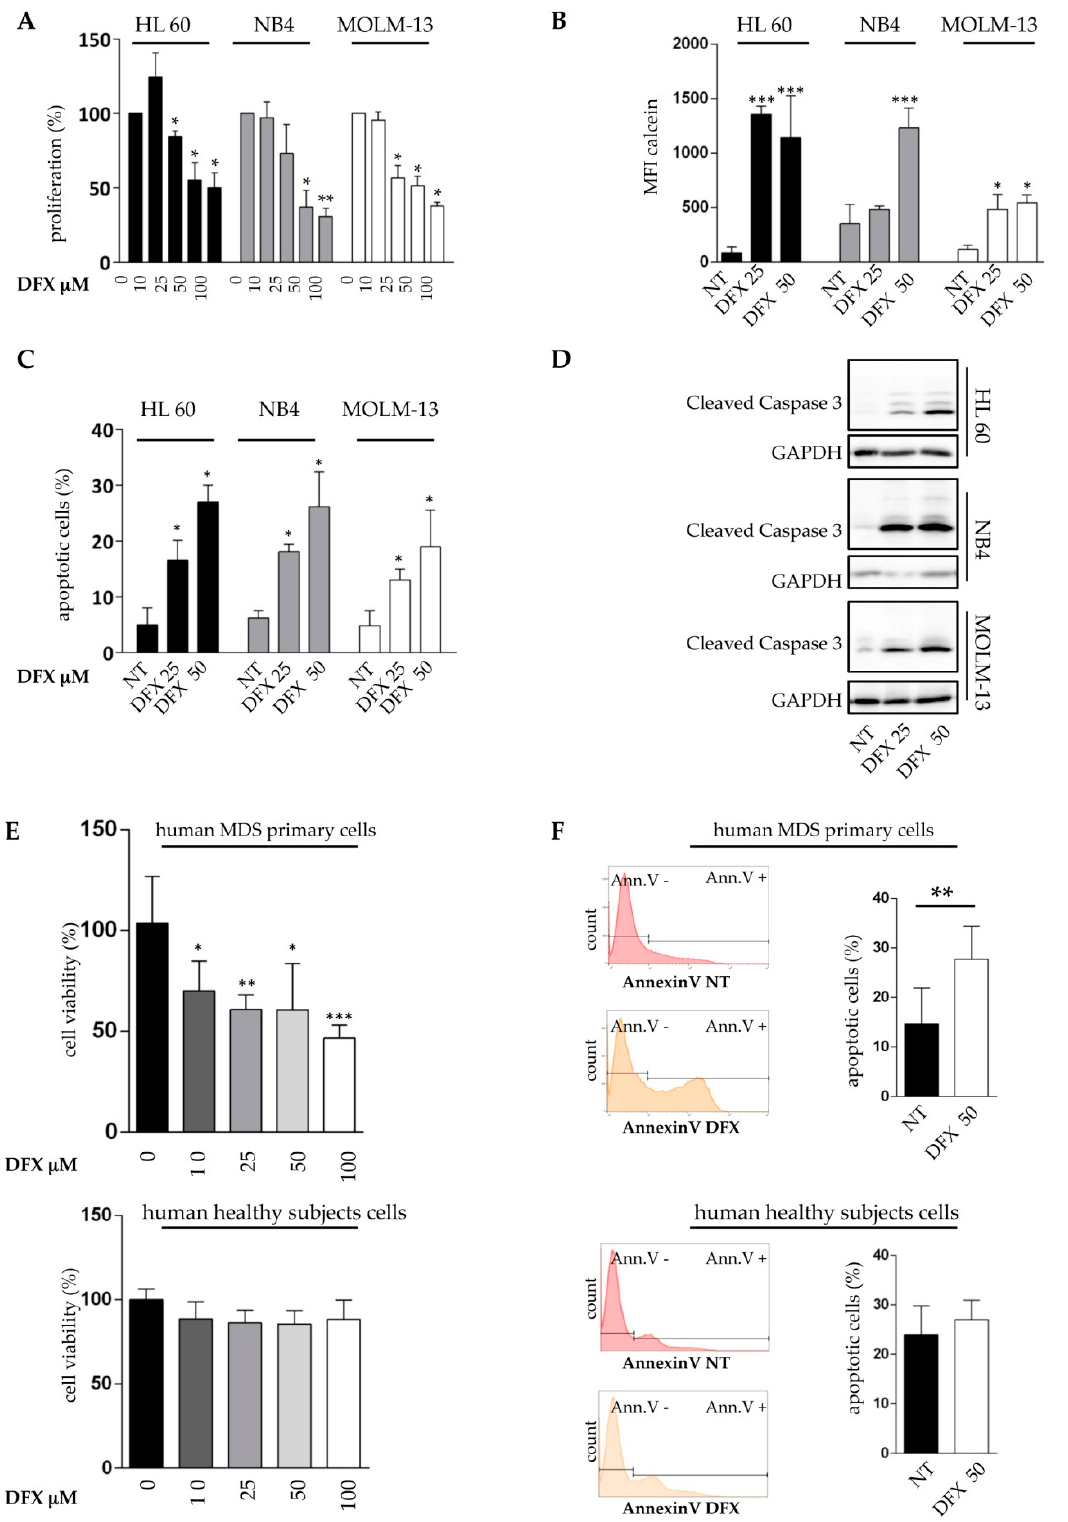
Figure 2. Deferasirox exerts an anti-leukemic activity on AML cell lines and on MDS patients’ cells. ( A ) HL60, NB4, and MOLM-13 were treated with 0, 10, 25, 50, or 100 µM DFX for 48 h and the MTT assay was performed to evaluate the proliferation index. The percentage of proliferation is expressed after normalizing with untreated cells (100%). ( B ) Mean fluorescence intensity (MFI) of FITC-calcein signal obtained after 48 h of DFX treatment. LIP level was inversely proportional to measured fluorescence intensity. ( C ) Percentage of apoptosis evaluated by flow cytometry after FITC Annexin-